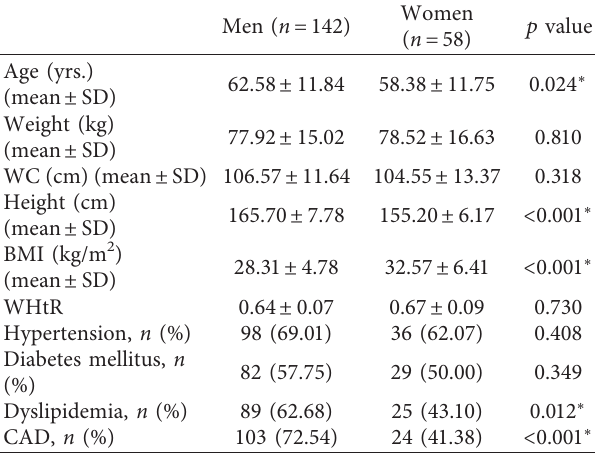
Table 1: Characteristics of participants.